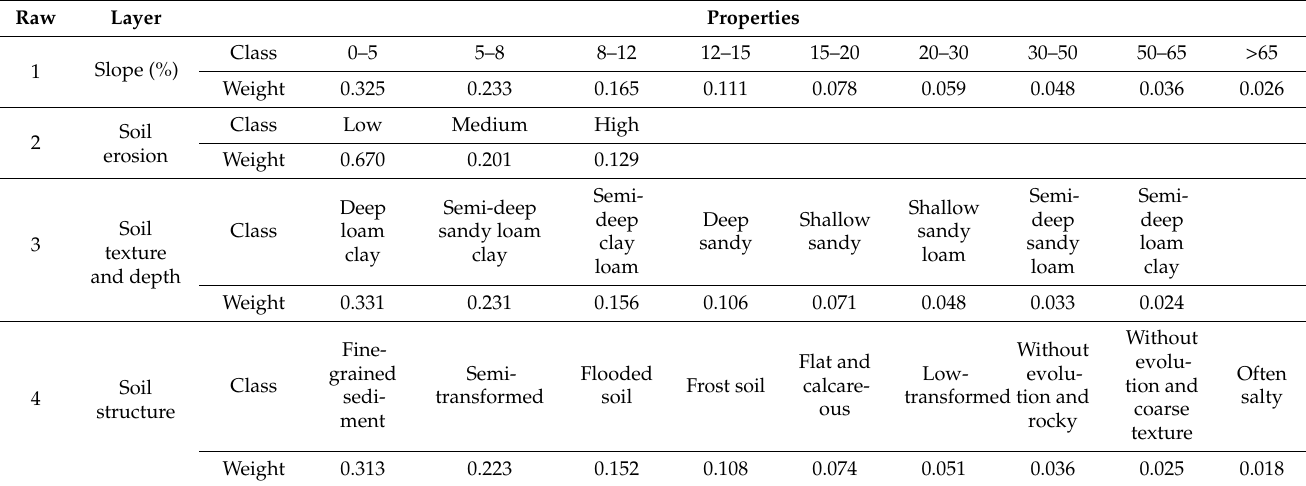
Table 2. Class and the associated weight of each layer in the aquaculture land evaluation of Markazi province.